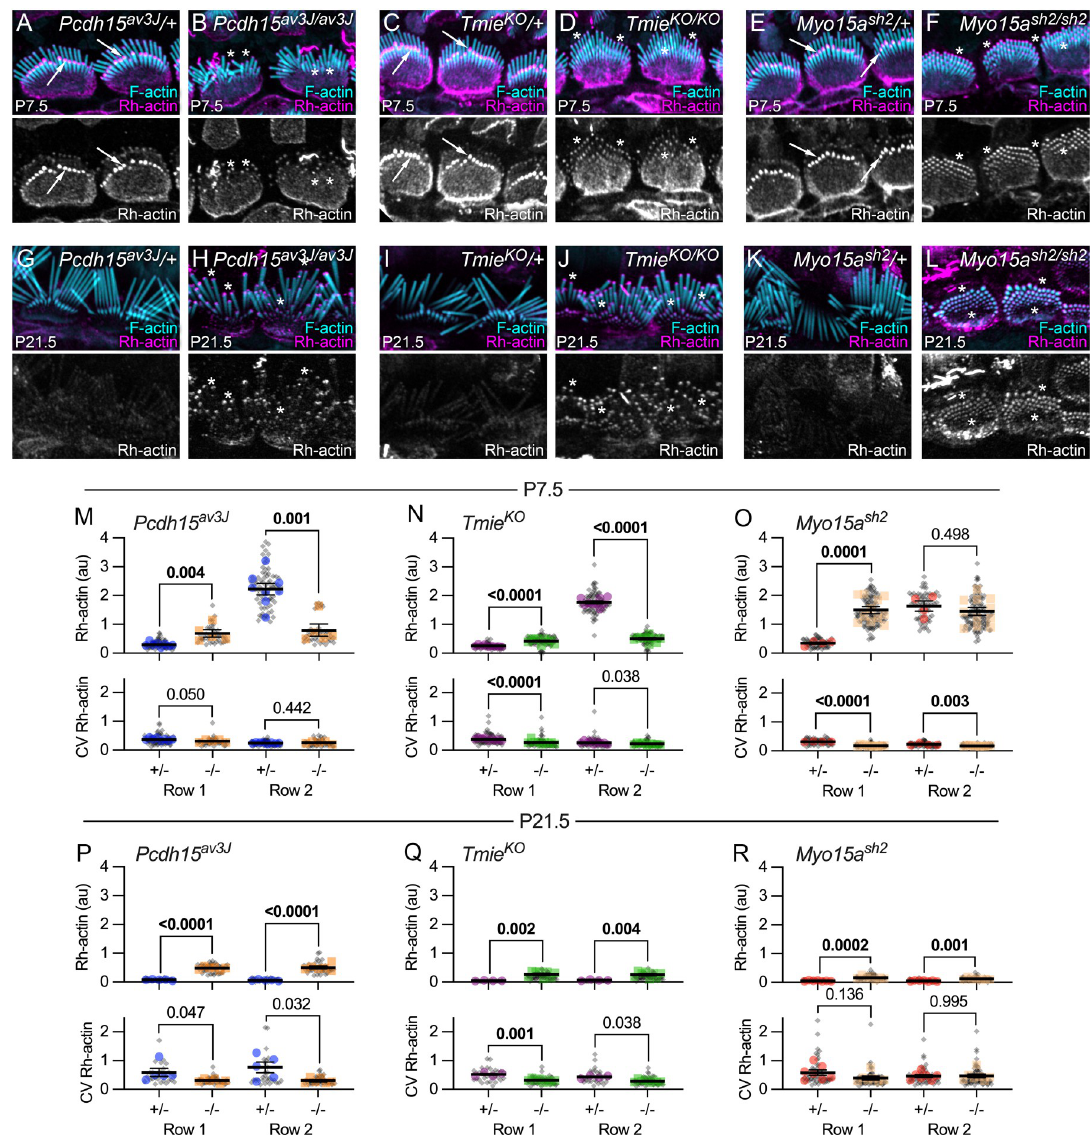
Fig 13. Free barbed end labeling of IHC stereocilia with rhodamine-actin. ( A–L ) Rhodamine-actin (Rh-actin) and phalloidin labeling of mutant IHC hair bundles at P7.5 and P21.5. Pcdh15 av3J (A–B, G–H), Tmie KO (C–D, I–J), and Myo15a sh2 (E–F, K–L). Arrows in A, C, and E indicate high levels of row 2 rhodamine-actin labeling in P7.5 control IHC bundles; asterisks in B, D, F, H, and J indicate similar rhodamine-actin levels at all stereocilia tips in P7.5 and P21.5 mutant IHC bundles. Panel widths: 24 μ m. ( M–R ) Rh-actin tip intensity and intensity CV in Pcdh15 av3 , Tmie KO , and Myo15a sh2 at P7.5 (M–O) and P21.5 (P–R). Plotting and statistical testing were as in Fig 3. The data underlying all the graphs shown in the figure can be found in figshare (https://doi.org/10.6084/m9.figshare.21632636.v2). CV, coefficient of variation; IHC, inner hair